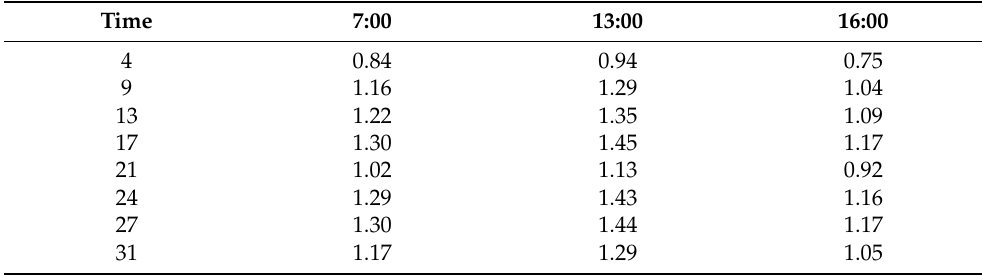
Table A2. The magnitude of the 5th harmonic current of each harmonic source at different times (A).